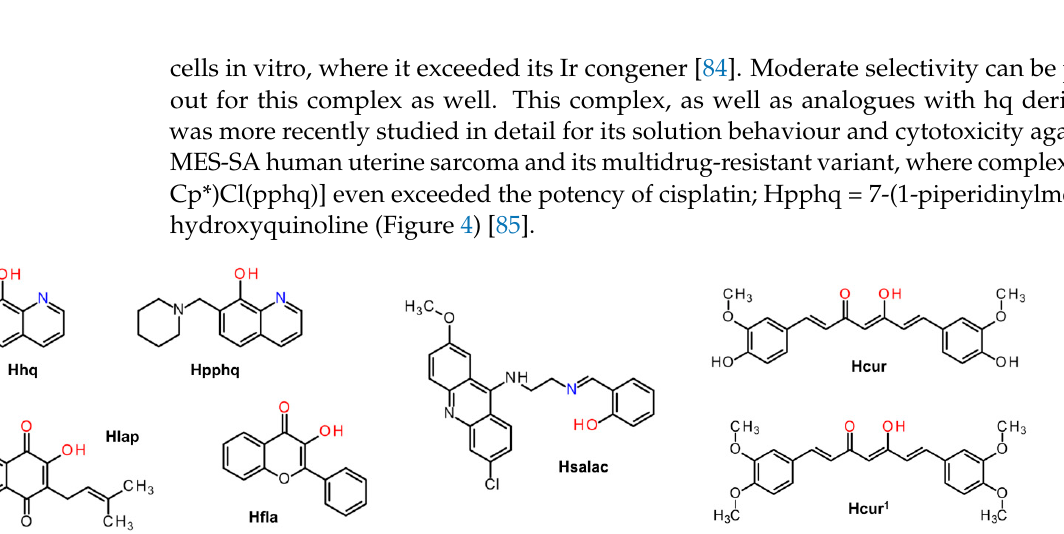
Figure 4. Structural formulas of selected bidentate N , O - and O,O -donor L^L ligands, with donor nitrogen and oxygen atoms given in blue and red, respectively.